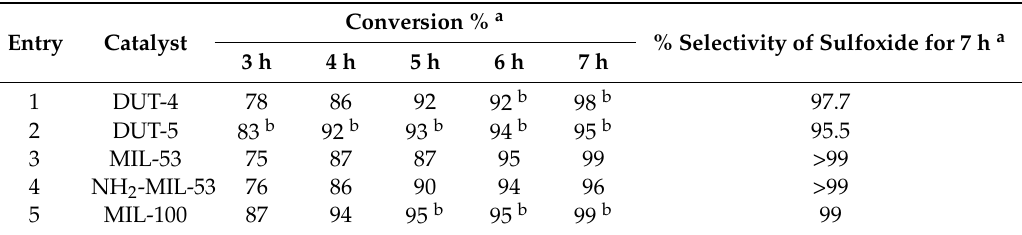
Table 4. Summary of selective oxidation of methyl phenyl sulfide to methyl phenyl sulfoxide catalyzed by Al-MOFs at 60 ◦